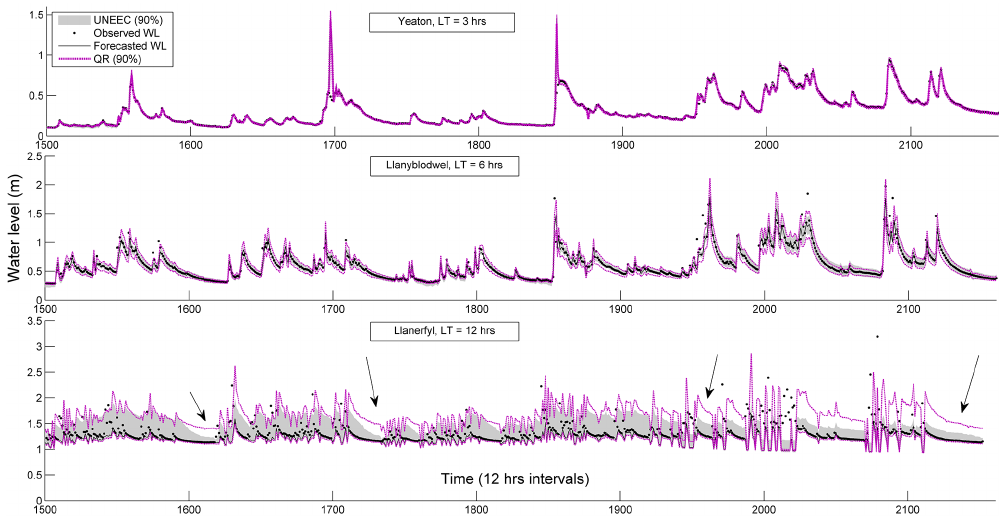
Figure 14. Comparison of prediction limits for the 90% confidence level during validation (1 April 2012–7 March 2013): Yeaton, lead time 3h (top); Llanyblodwel, lead time 6h (middle); and Llanerfyl, lead time 12h (bottom).